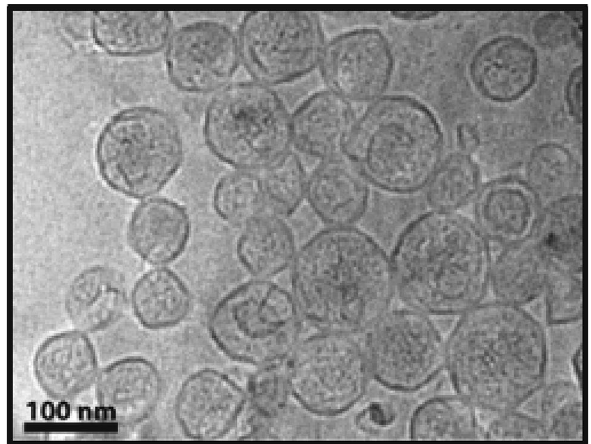
Figure 1. Representative cryo-TEM micrograph of the thermoLUM liposomes.